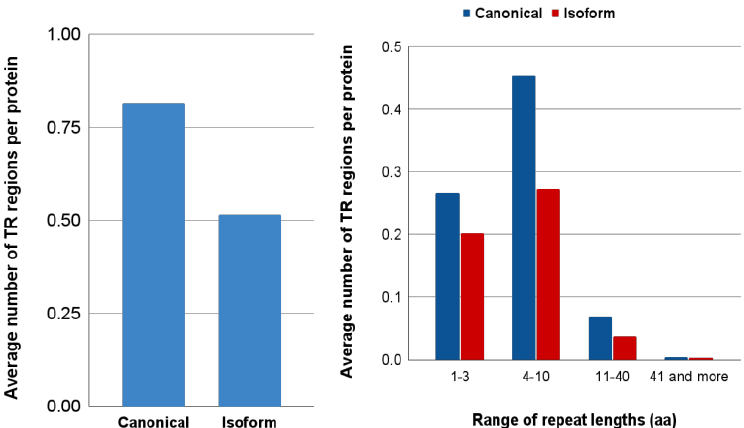
Figure 7. ( A ) Average number of tandem repeat regions determined per protein by MRF tool; ( B ) Distribution of proteins with tandem repeat by the length of their repetitive